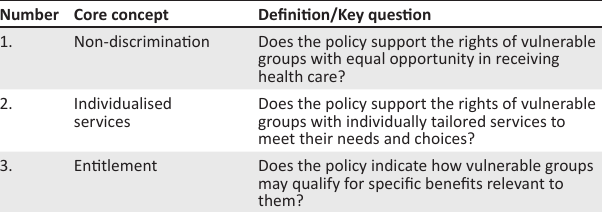
TABLE 1: EquiFrame : Key questions and key language of core